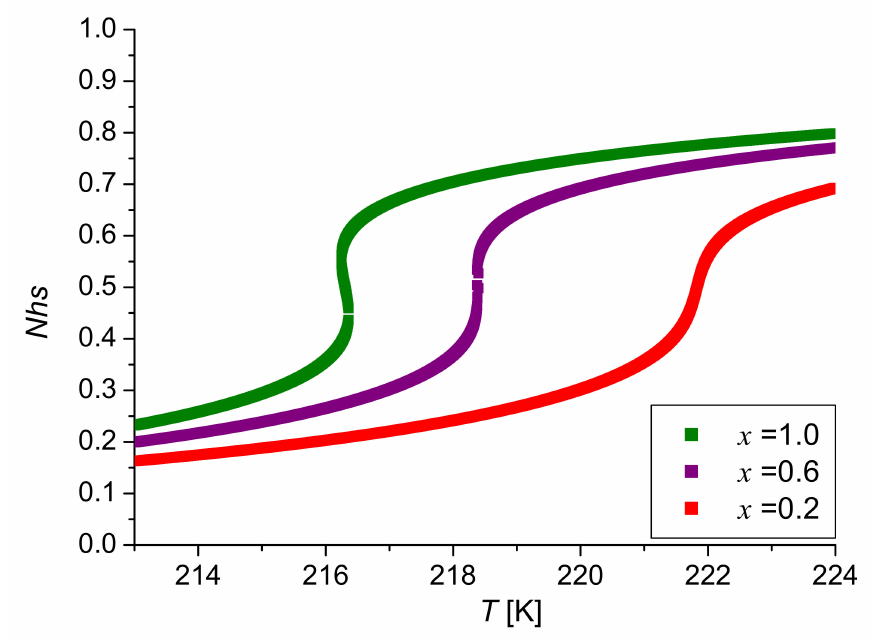
Figure 7. Thermal evolution of the HS fraction in a SCO system with a size of 6 × 6 for different values of the x parameter: x = 1.0 (green square), x = 0.6 (purple square) and x = 0.2 (red square). The computational parameters are: ∆ / k B = 1300 K, J / k B = 14.8 K, G / k B = 172.2 K and ln( g ) = 6.01.